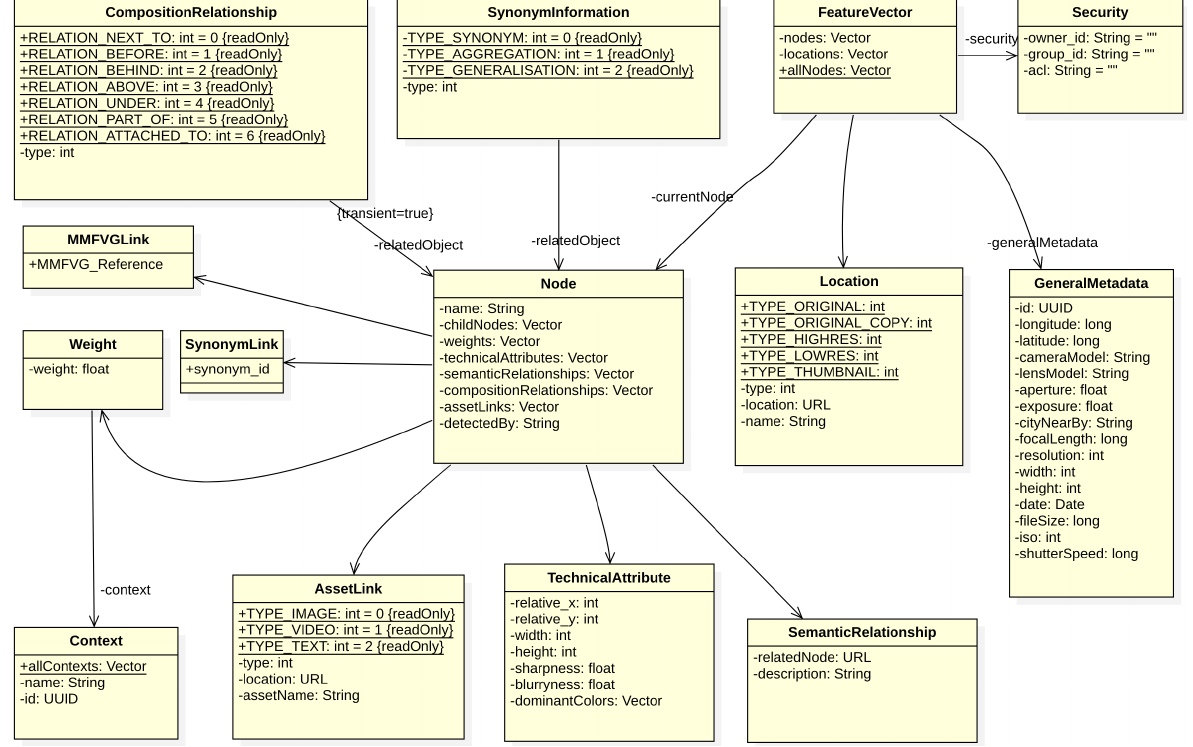
Figure 4. UML class diagram of the MMFVG